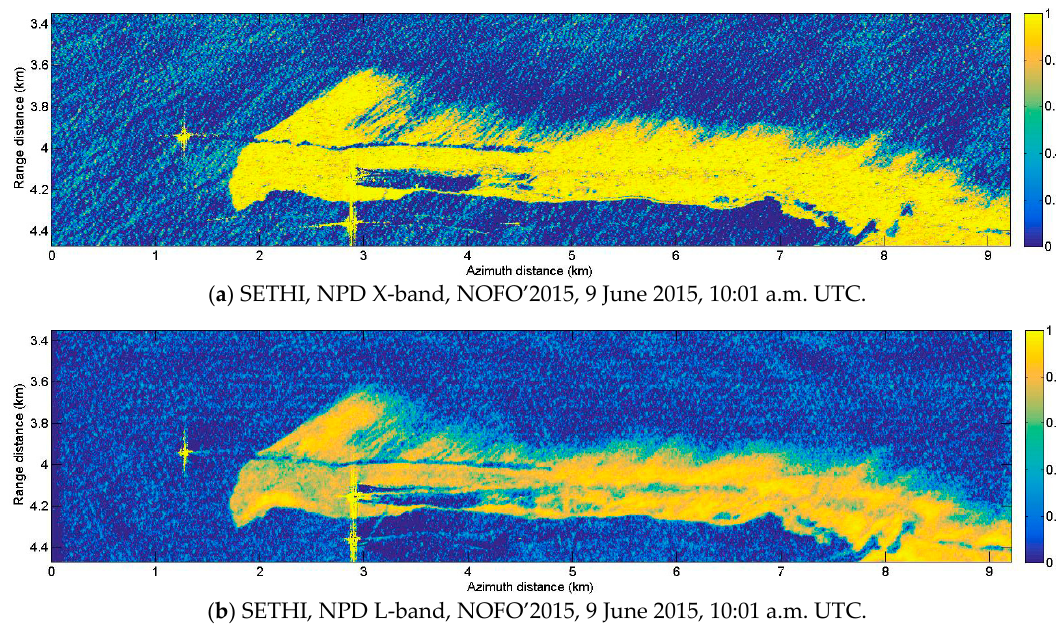
Figure 16. SETHI NOFO’2015 on 9 June 2015 at 10:01 a.m. UTC, NPD parameter at: ( a ) X-band and ( b ) L-band (multi-look 7 × 7).